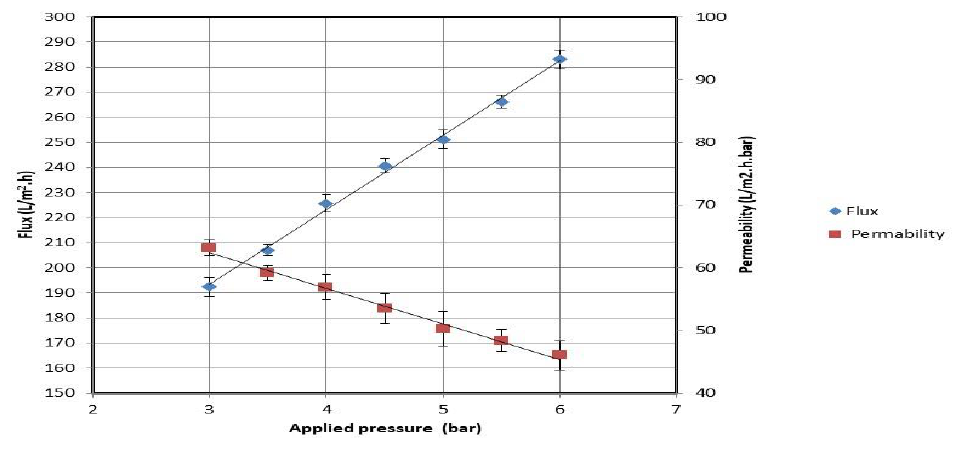
Figure 8. Water flux rate and permeability of fabricated membrane at different pressures.